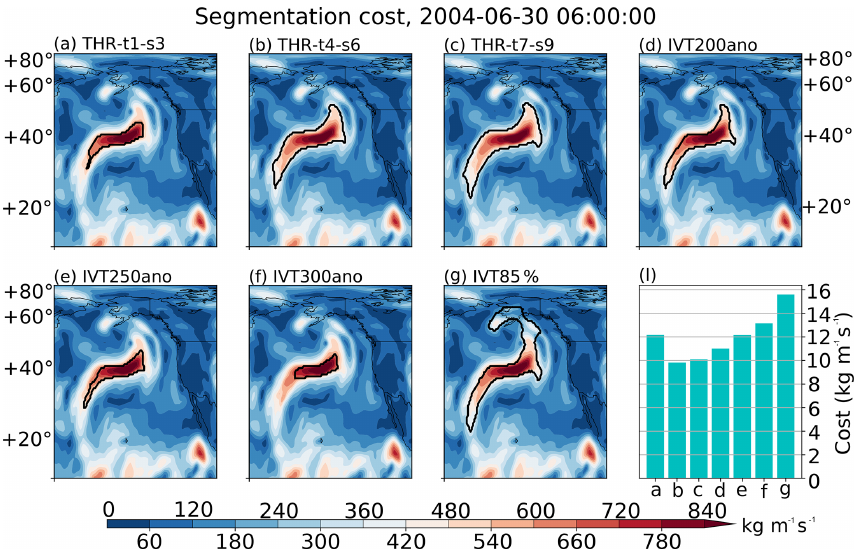
Figure A3. IVT distribution on 30 June 2004 at 06:00UTC over the northeastern Pacific (in kgm − 1 s − 1 ). Boundaries of ARs detected by